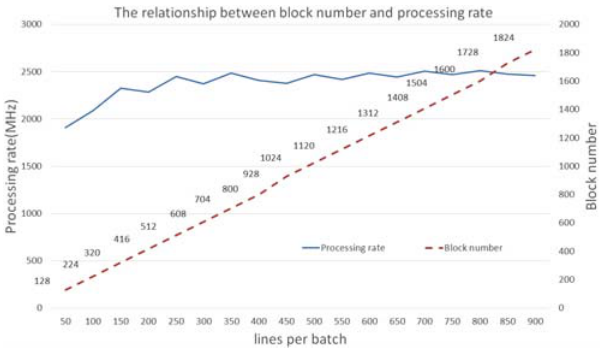
Fig. 3. Grid size and processing